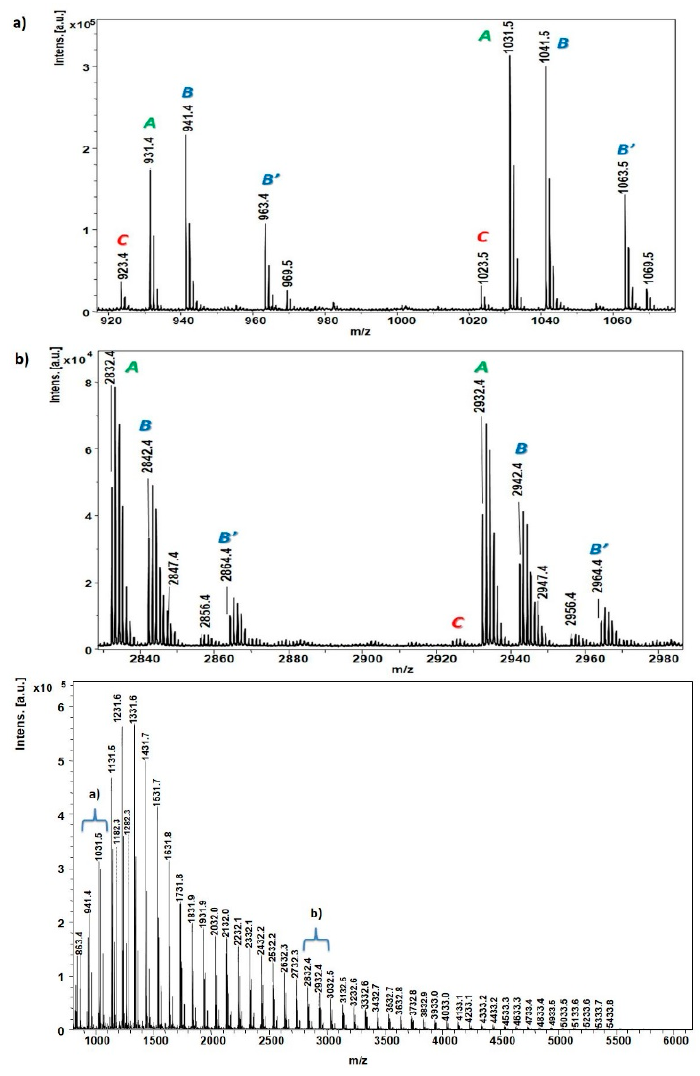
Figure 6. MALDI-TOF-MS spectrum (positive ion mode) of poly( δ -valerolactone) together with two spectral expansions in the mass range: ( a ) m/z 910–1100 and ( b ) m/z 2810–3090 (Sample 2, Table 1).